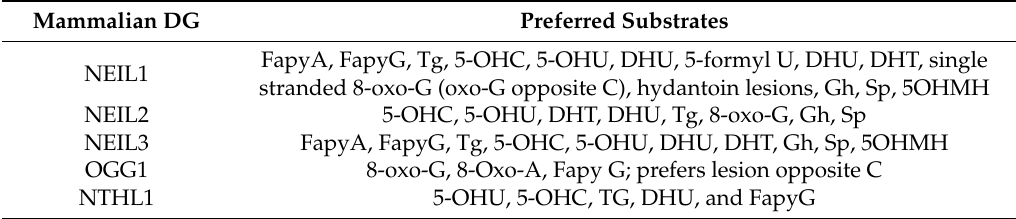
Table 1. Common and unique substrates of mammalian DNA glycosylases (DGs). Mammalian